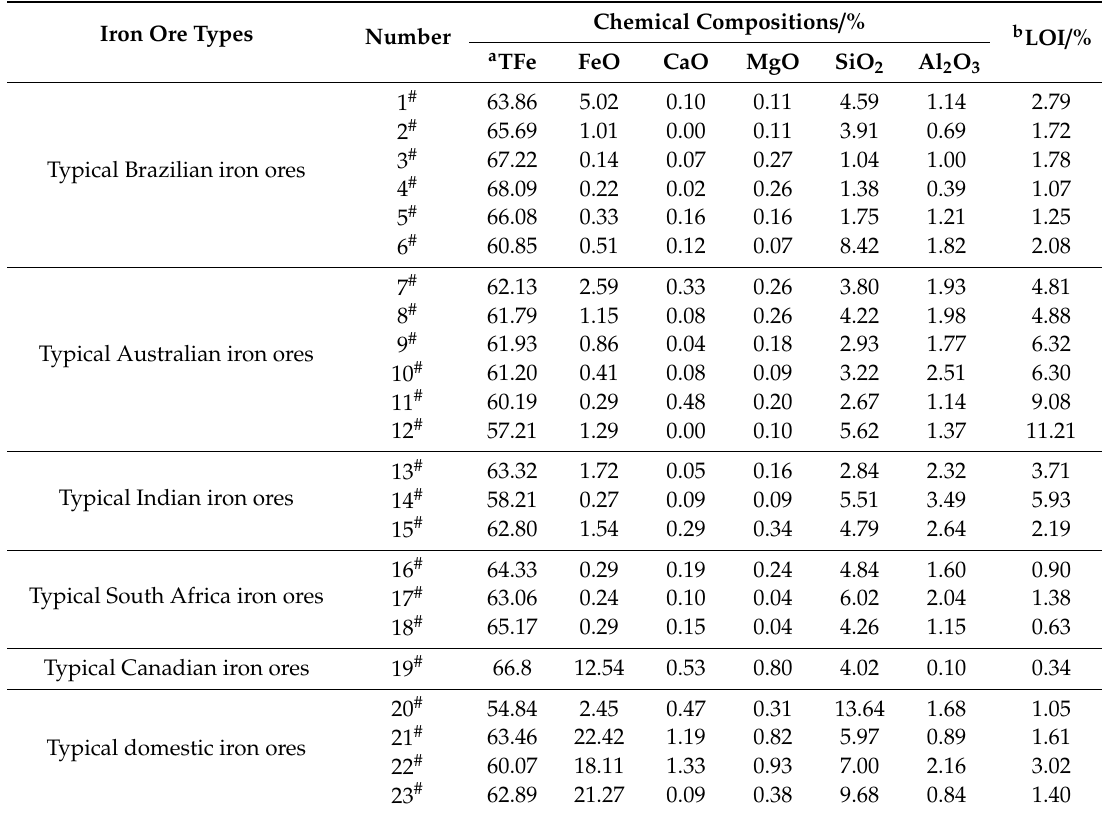
Table 1. Chemical compositions of iron